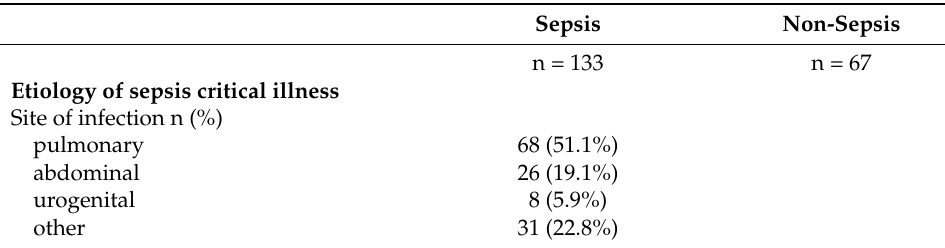
Table 2. Etiology of disease in the study